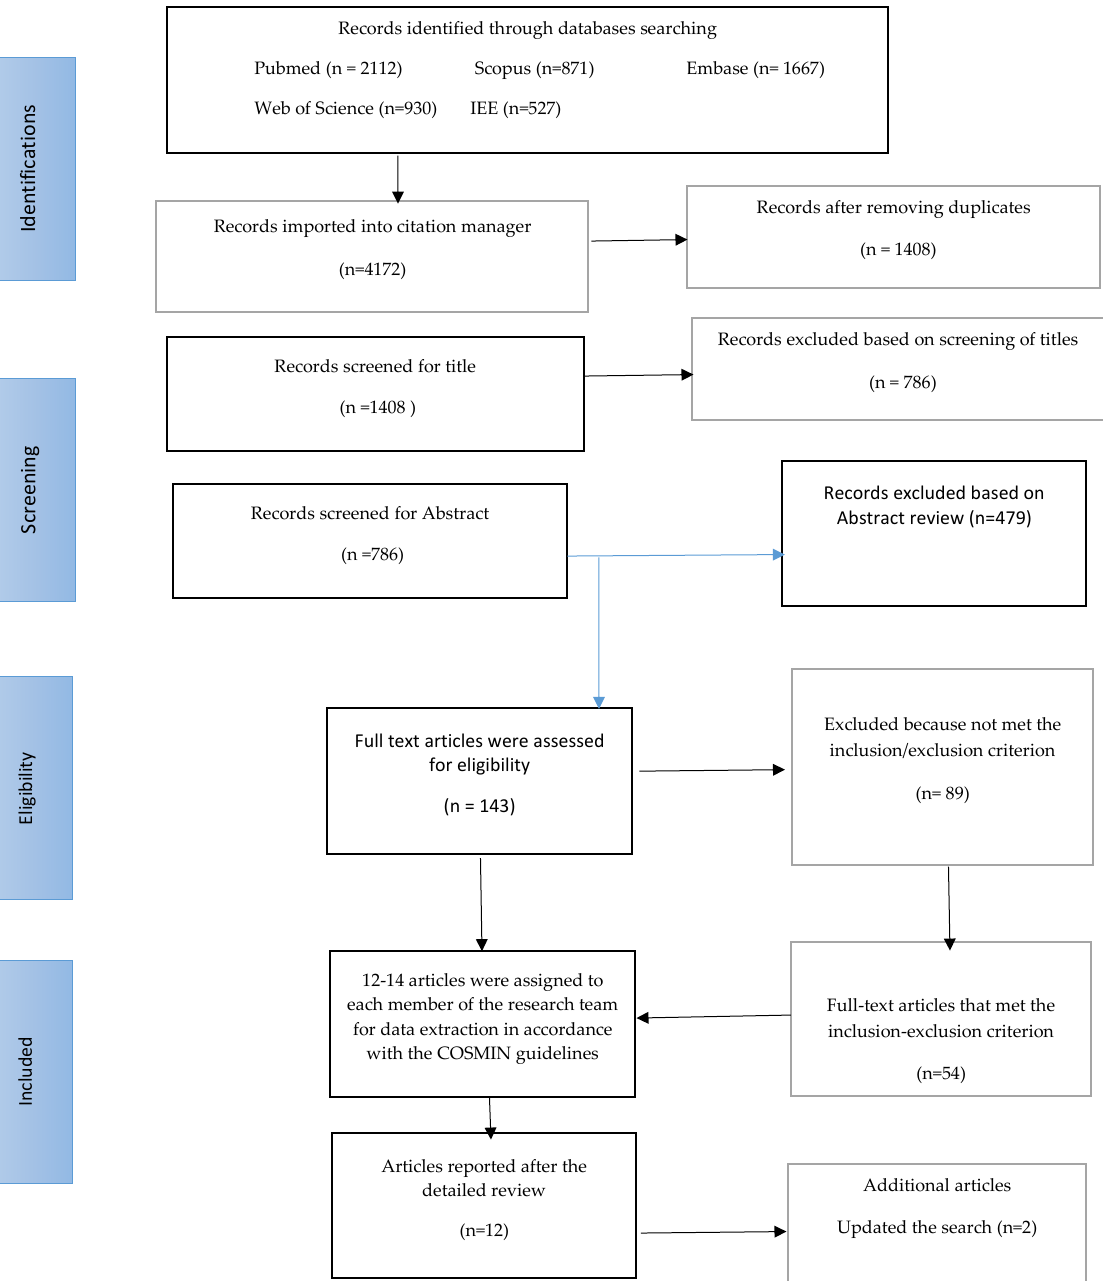
Figure 1. PRISMA (Preferred Reporting Items for Systematic Reviews and Meta-Analyses) flow